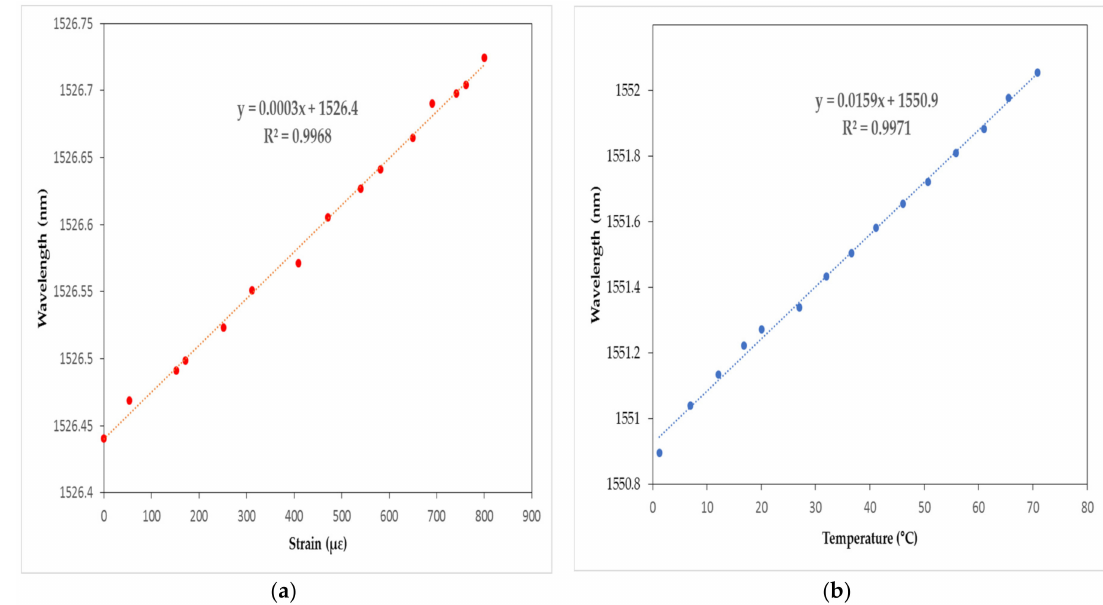
Figure 7. Calibration results of FBG: ( a ) strain sensor; and ( b ) temperature sensor.